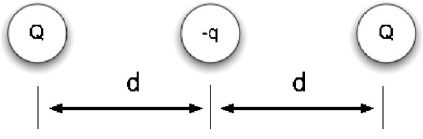
FIG. 11. Figure for the two-dimensional three-charge problem.